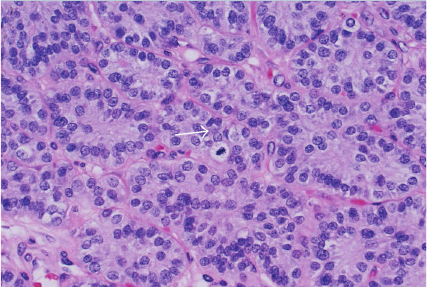
Figure1:Parathyroidtumorcapsulesurroundingthesofttissue,20x magnification.